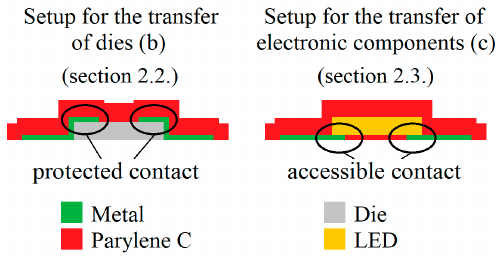
Figure 2. Difference in test setup for the transfer of dies (b) and electronic components (c) with Parylene-protected contact areas and accessible contact areas, respectively.